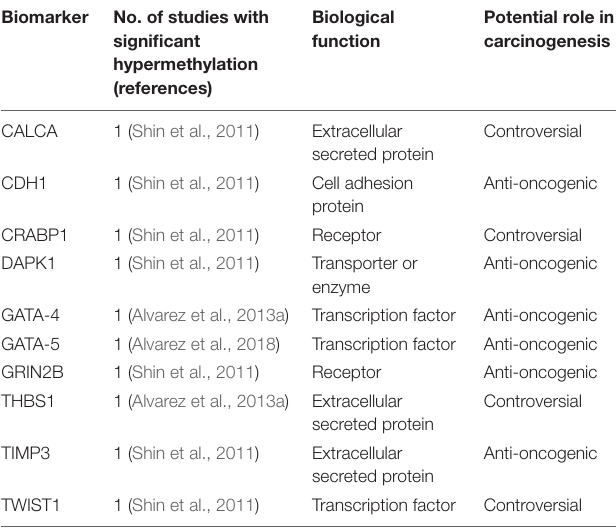
Biomarker No. of studies with